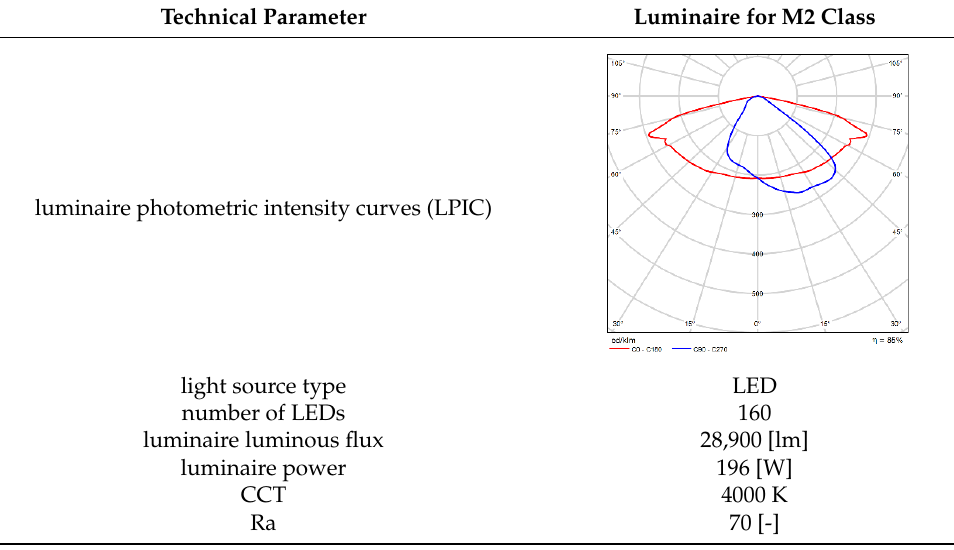
Table 6. Luminaire placement ranges.